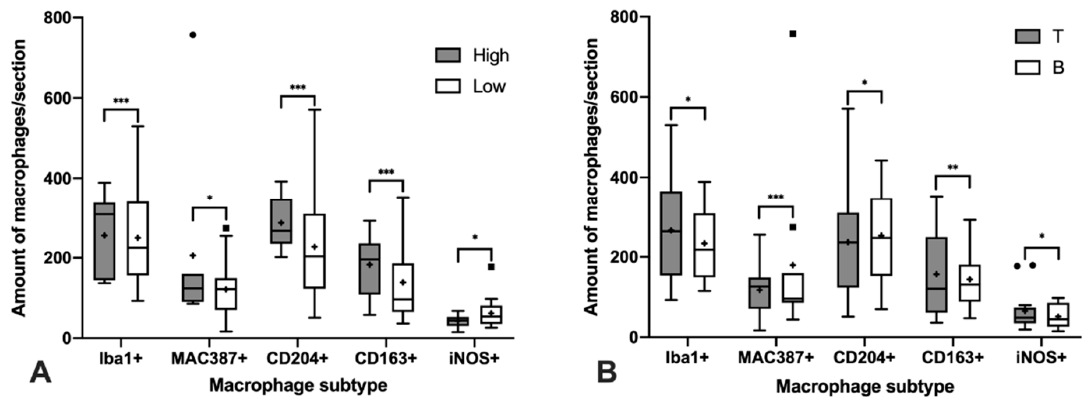
Figure 1. Significant differences in the median of the amount of macrophage subtypes per sample according to the histological grade ( A ) and immunophenotype ( B ). Black squares and circles represent outlayer data. *, p < 0.05; **, p < 0.01; ***, p < 0.001.